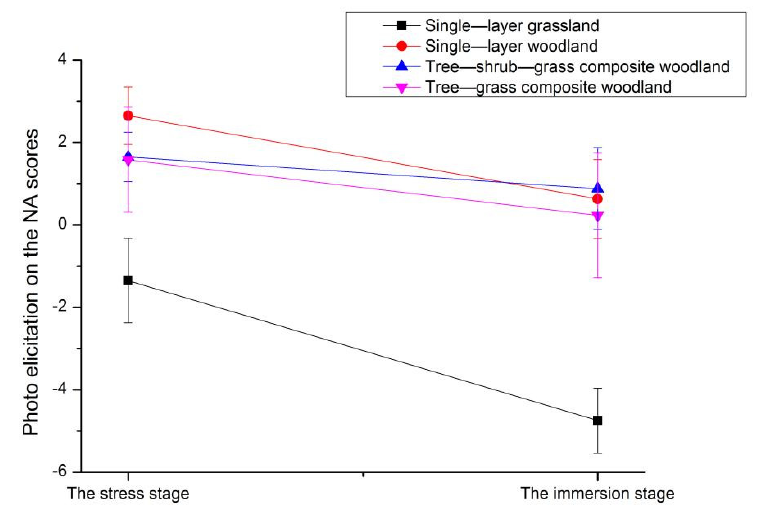
Figure 9. Effect of photo elicitation on the PA scores of participants.